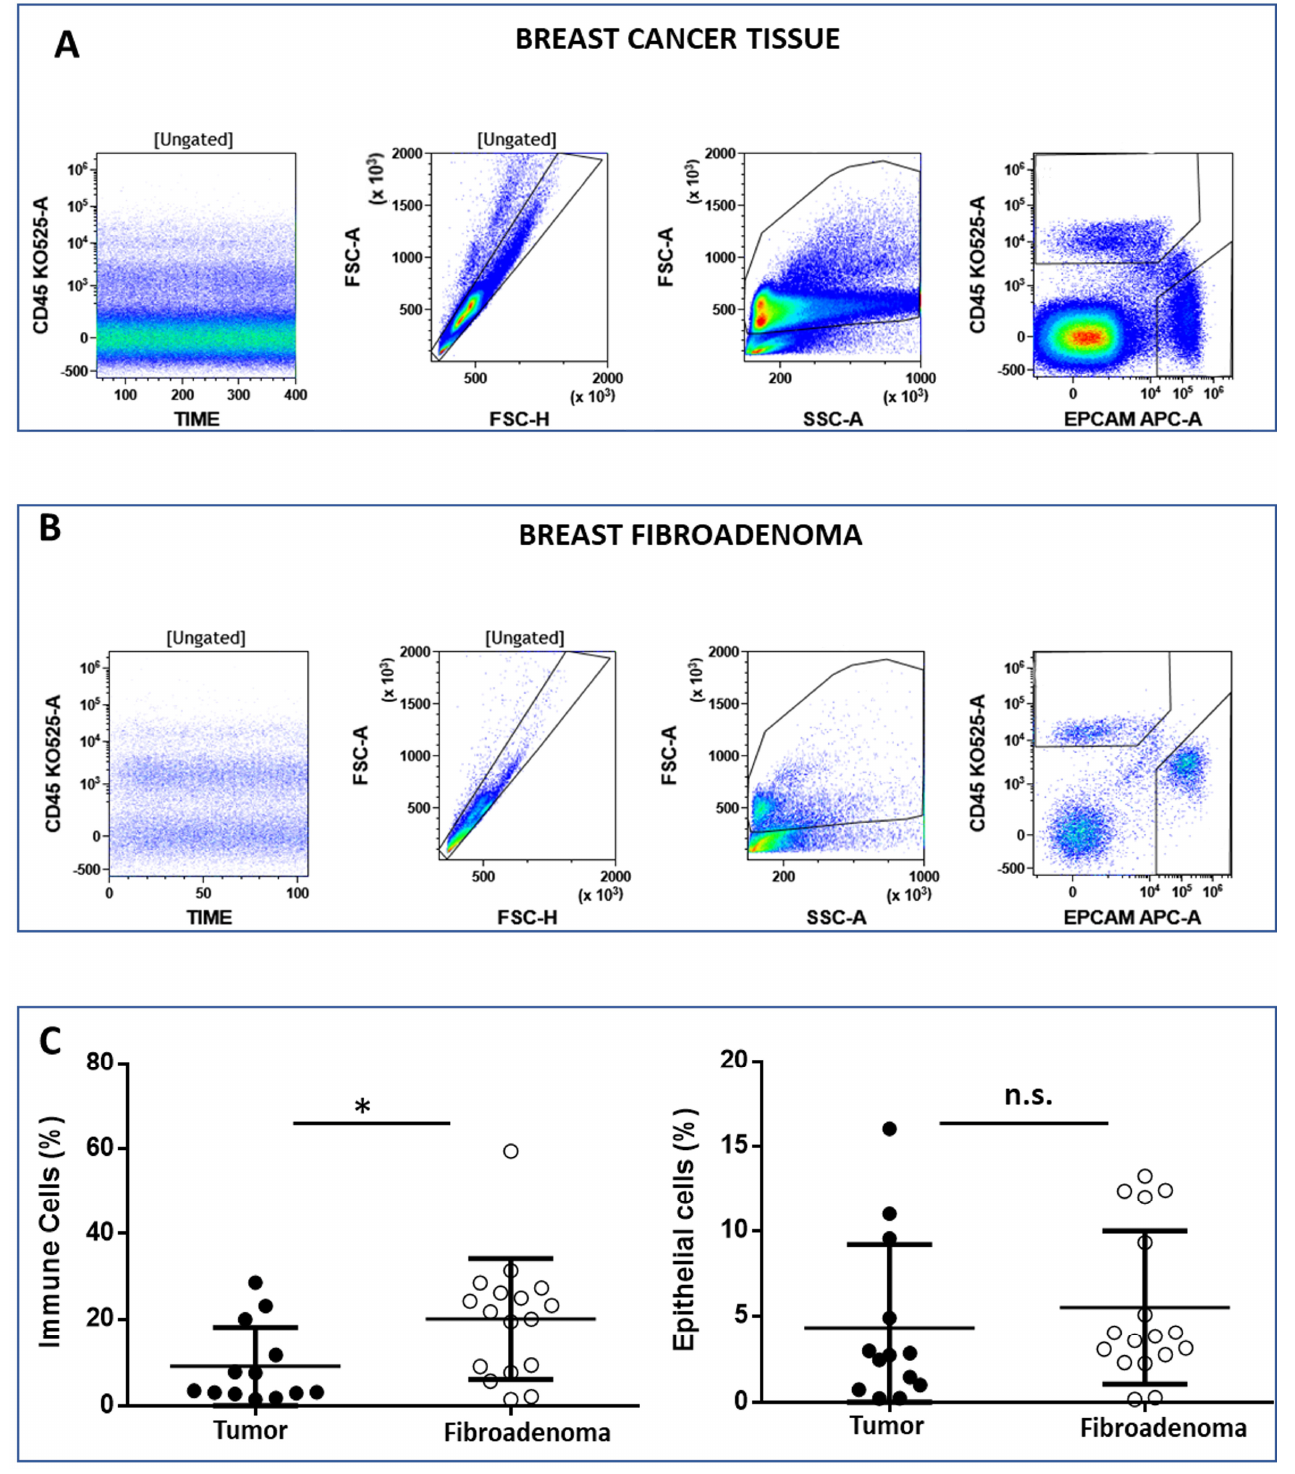
Figure 2. Panel ( A ) and ( B ) show the flow cytometry gating strategy to discriminate between lymphoid (CD45 pos/ EpCAM neg ) and epithelial (CD45 neg /EpCAM neg ) cells. The CD45 vs. time dot plot was examined to evaluate the absence of electronic noise during the acquisition; the FSC-A vs. FSC-H plot to exclude doublets; and then the physical parameters FSC-A vs. SSC-A to select live cells and exclude debris. Panel ( C ) shows the median percentage of immune and epithelial cells in both the breast tumor and fibroadenoma samples. * = p -value < 0.05 unpaired t -test. n.s. = not